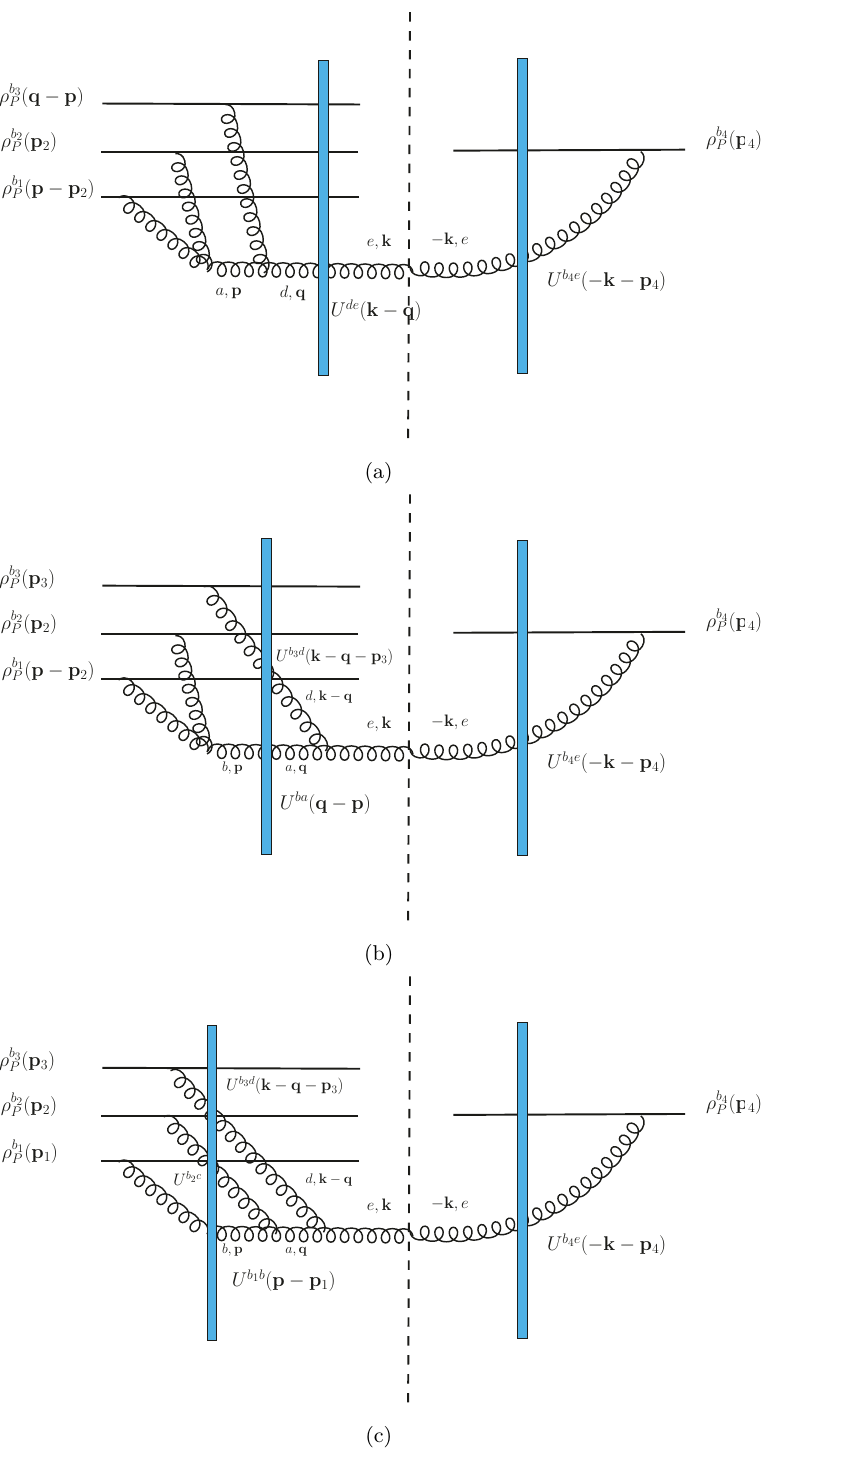
that contain two, three and four Wilson M (5) (1)